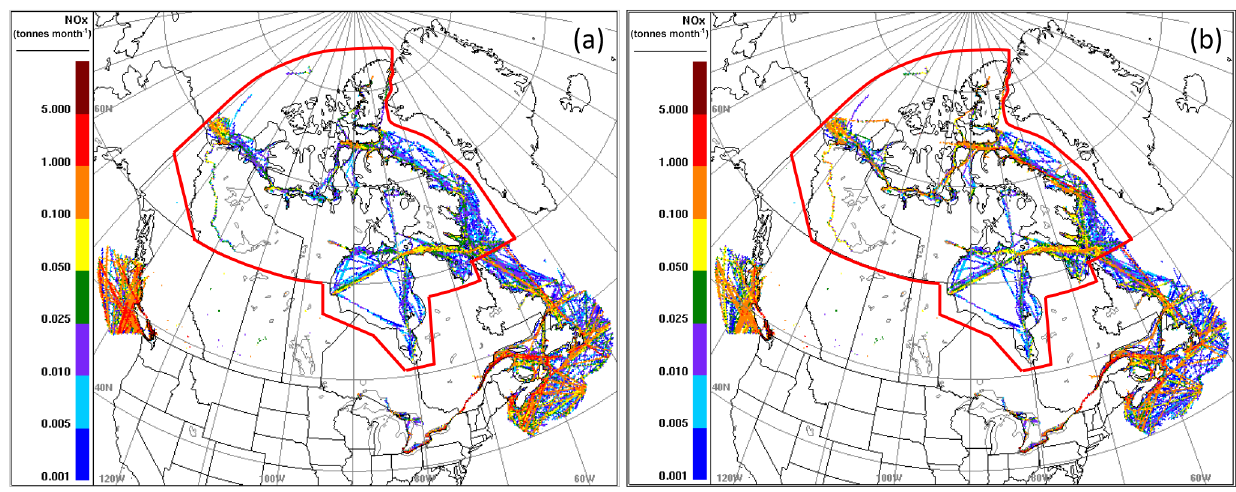
Figure 2. Processed model-ready NO x marine shipping emissions for August (a) 2010 and (b) projected 2030 BAU over Canadian waters, the red line outlining the Arctic region (including Hudson Bay) which is excluded from the current North American ECA designation. Table 4. Regional evaluation for O 3 , PM 2 . 5 , NO 2 , and SO 2 (hourly statistics). Geographical No. of MB